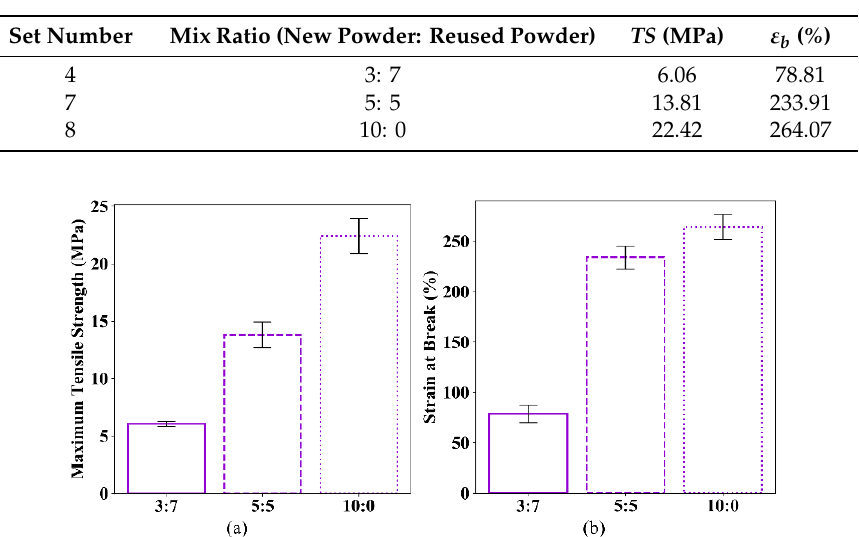
Figure 14. Comparison of the moduli at different strains of specimens. “Y” indicates specimens with post-processing, and ”N” means specimens without post-processing.